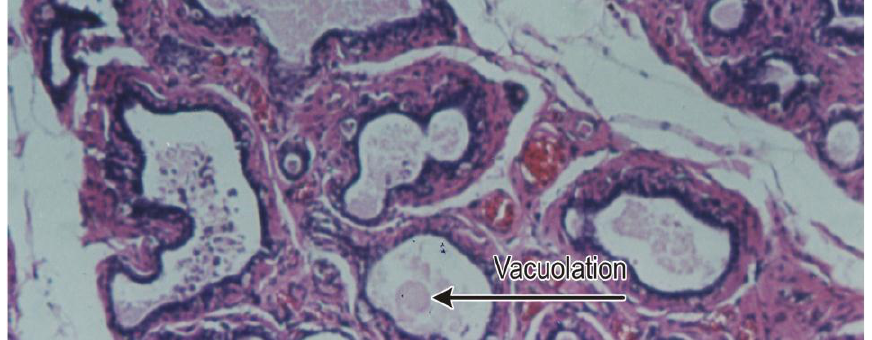
Figure – 5: Cross section from prostate of castrated treated rat showing vacuolation and atrophy in the secretory cells ( H&E stain, X10).